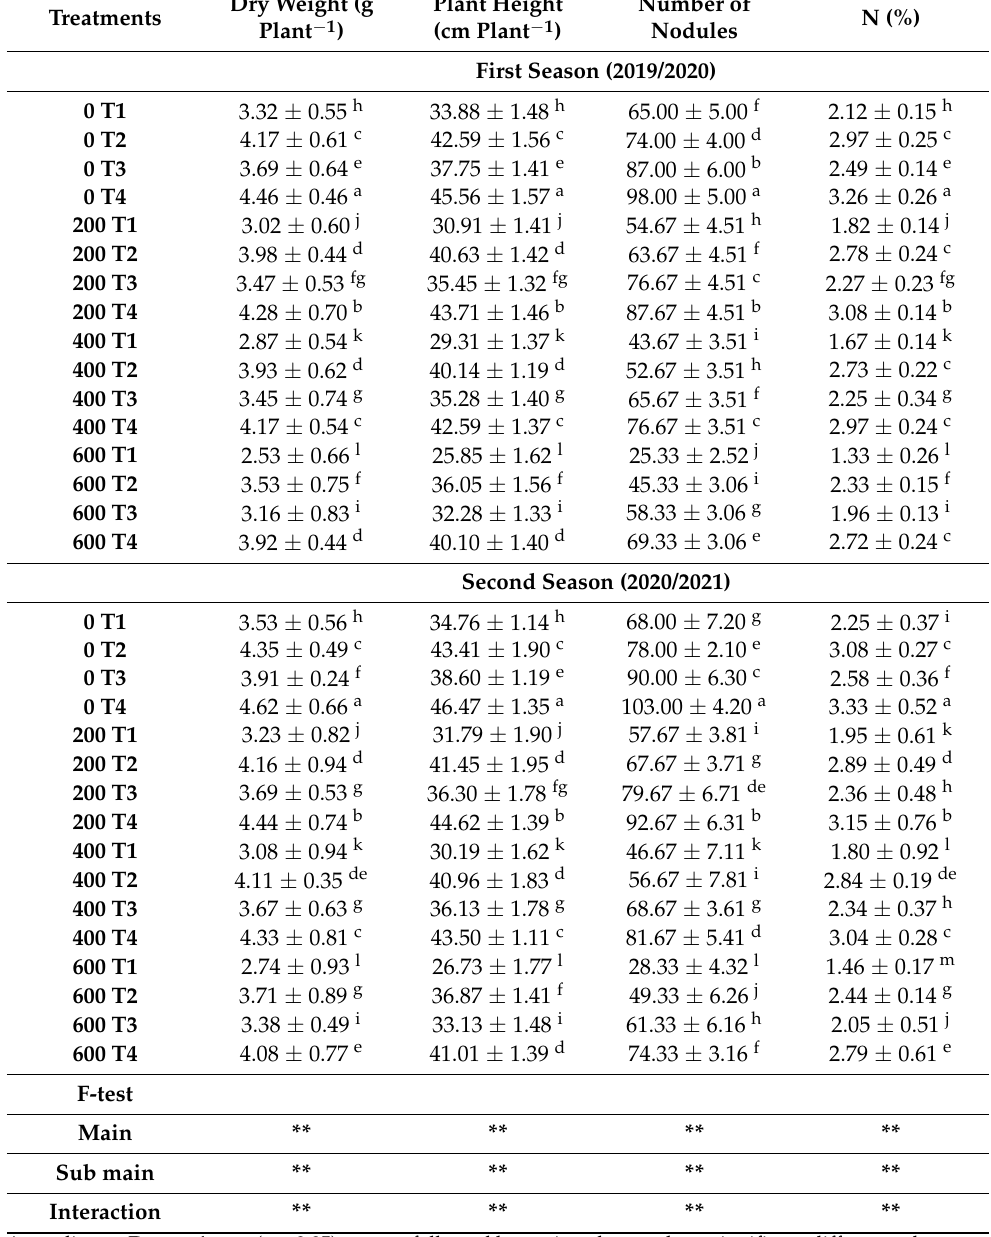
Table 2. Interaction effect of different concentrations of Ni and bacterial inoculation on the dry weight, plant height, number of nodules, and N% in faba bean plants at 60 days after sowing during